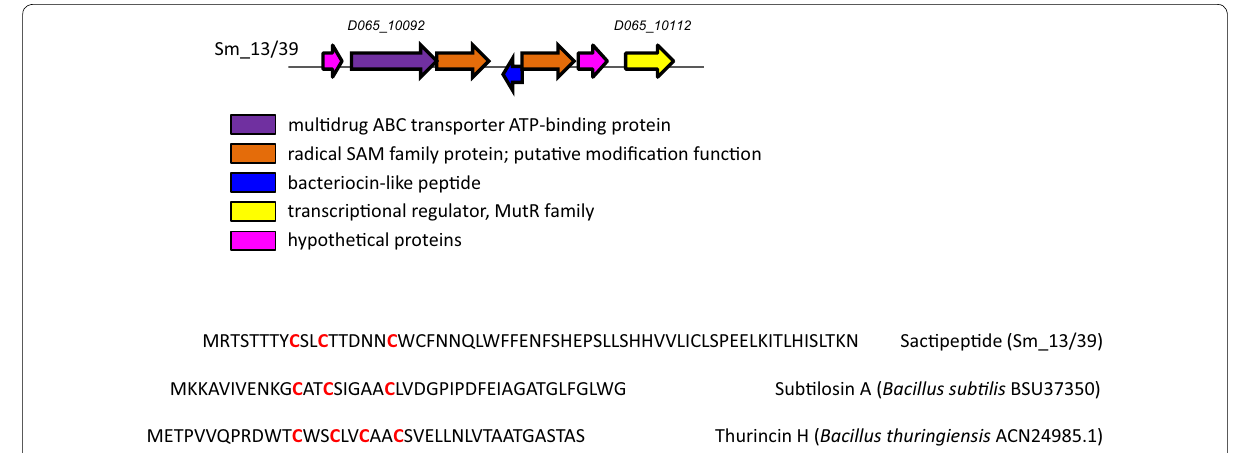
Fig. 4 Sactipeptide cluster structure on the data of Sm_13/39 genome analysis. In the bottom of picture, the AA sequence of putative bacteriocin discovered in the Sm_13/39 genome is given compared with known sactipeptides, subtilosin A and thurincin H